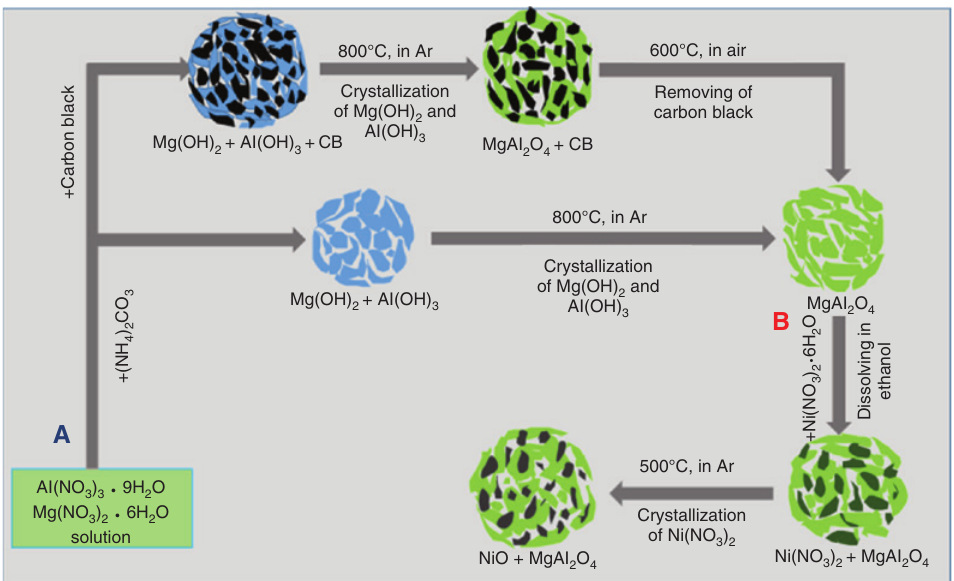
O catalysts: (A) supports synthesis by the co-precipitation method 2 4